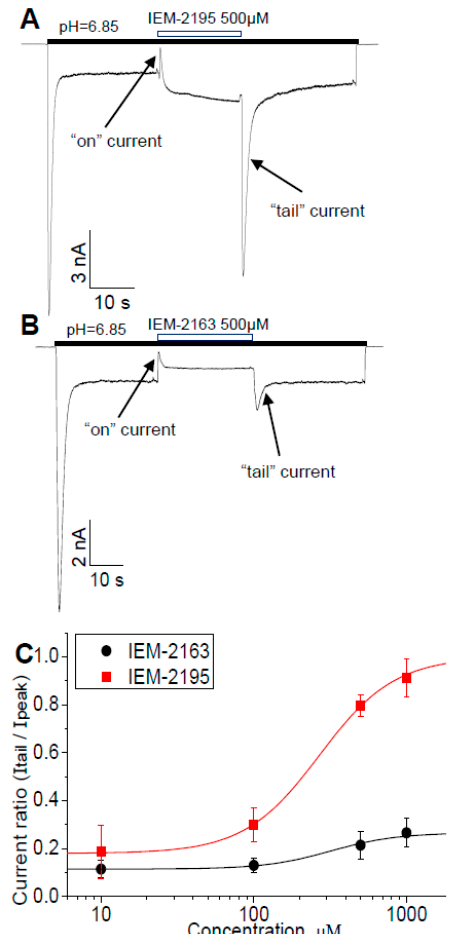
Figure 6. IEM-2163 and IEM-2195 cause transient currents when applied to sustained response. ( A , B ) Representative recordings. Fast drug application caused transient current decrease (“on” current), while washout induced transient increase (“tail” current). These transients reflect the presence of two opposite effects with different kinetics. ( C ) Concentration dependencies of “tail” currents.